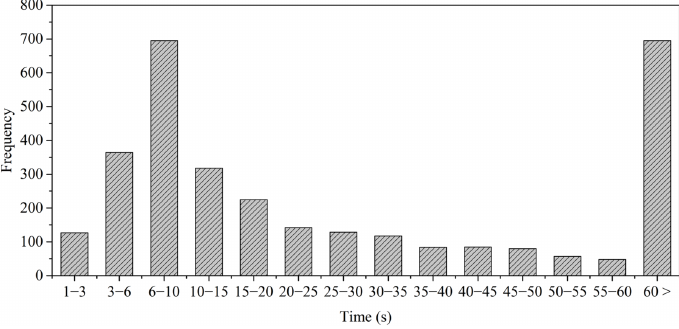
Figure 2. Histogram of the duration of drowsy driving in the dataset.